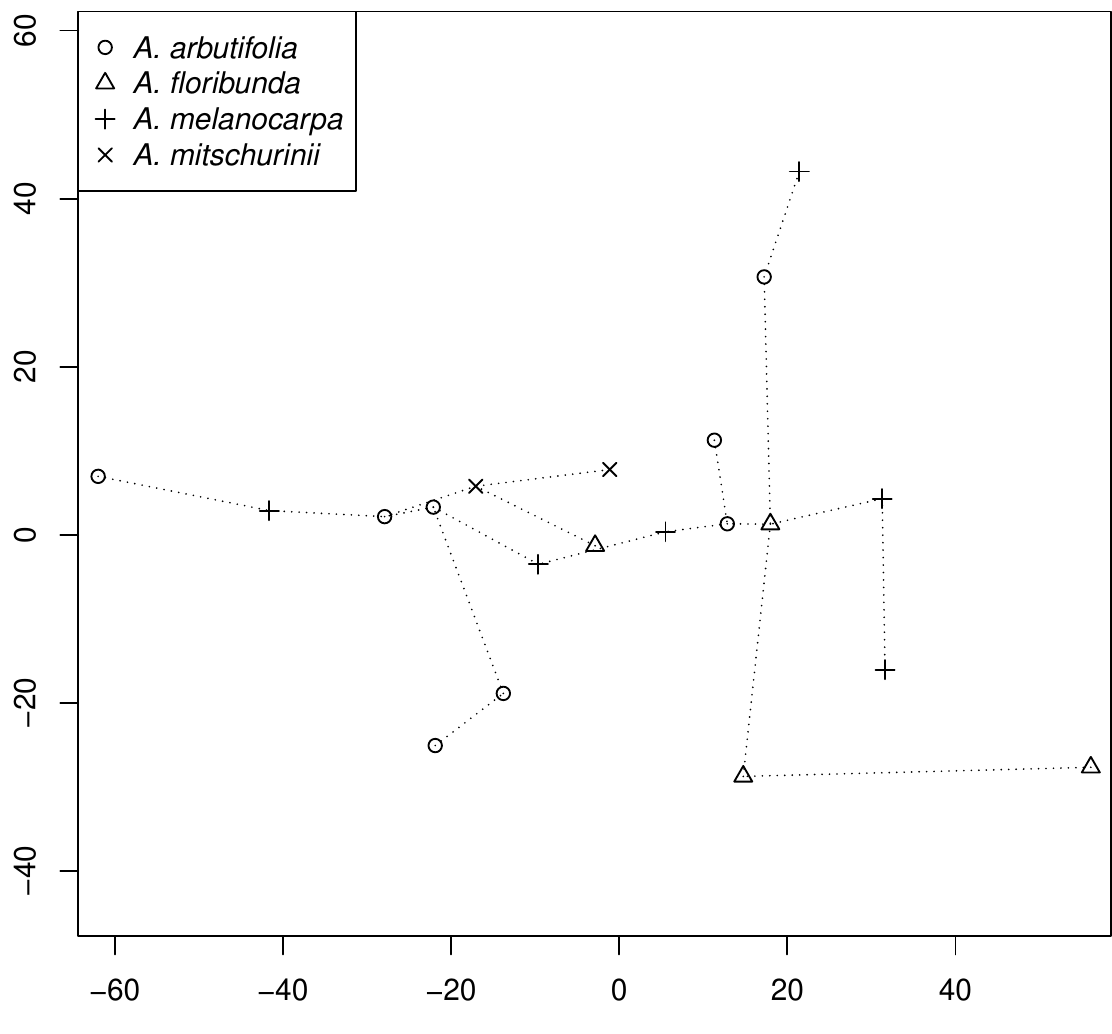
Fig. 6. Ordination from multidimensional scaling of the Gower distance matrix from the combined dataset of haplotypes occurrence and